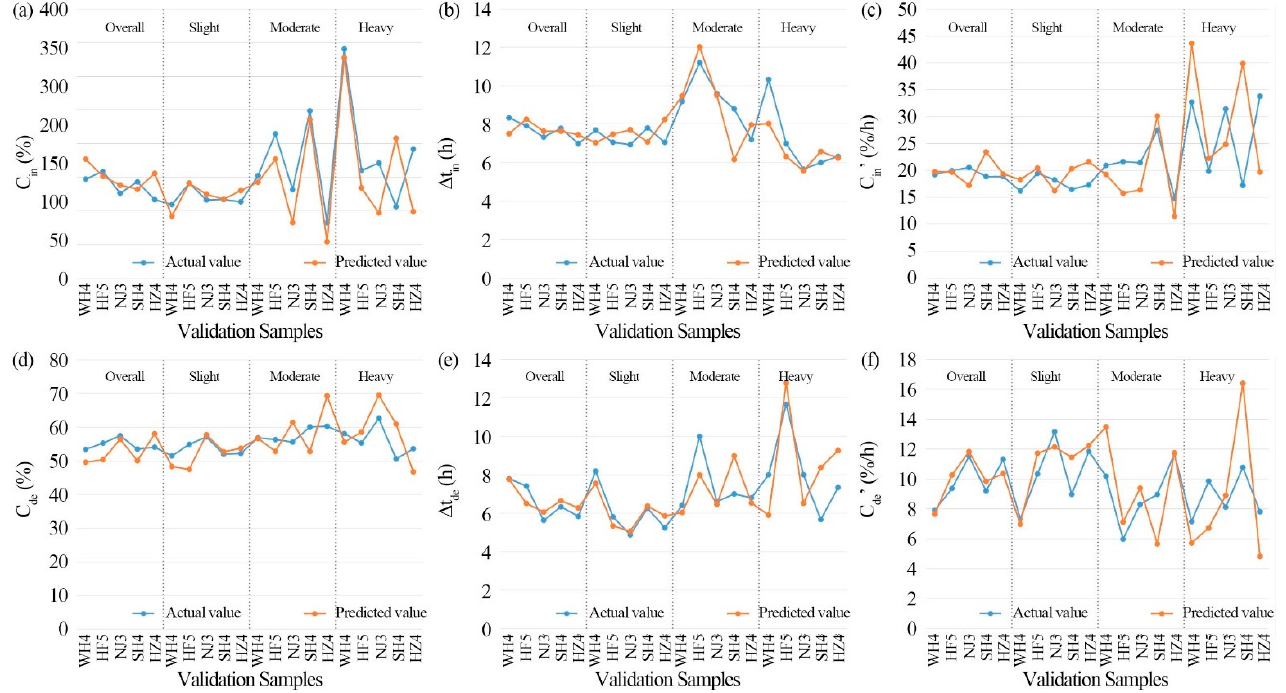
Figure 4. Validation for regression models of six PM 2.5 indicators at the different pollution levels. ( a ) C in ; ( b ) Δ t in ; ( c ) C in ’; ( d ) C de ; ( e ) Δ t de ; ( f ) C de ’.